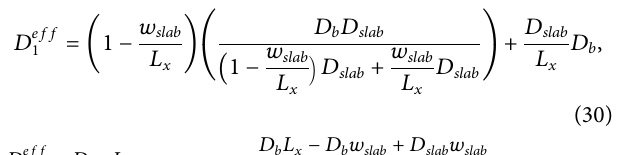
Frontiers in Materials |